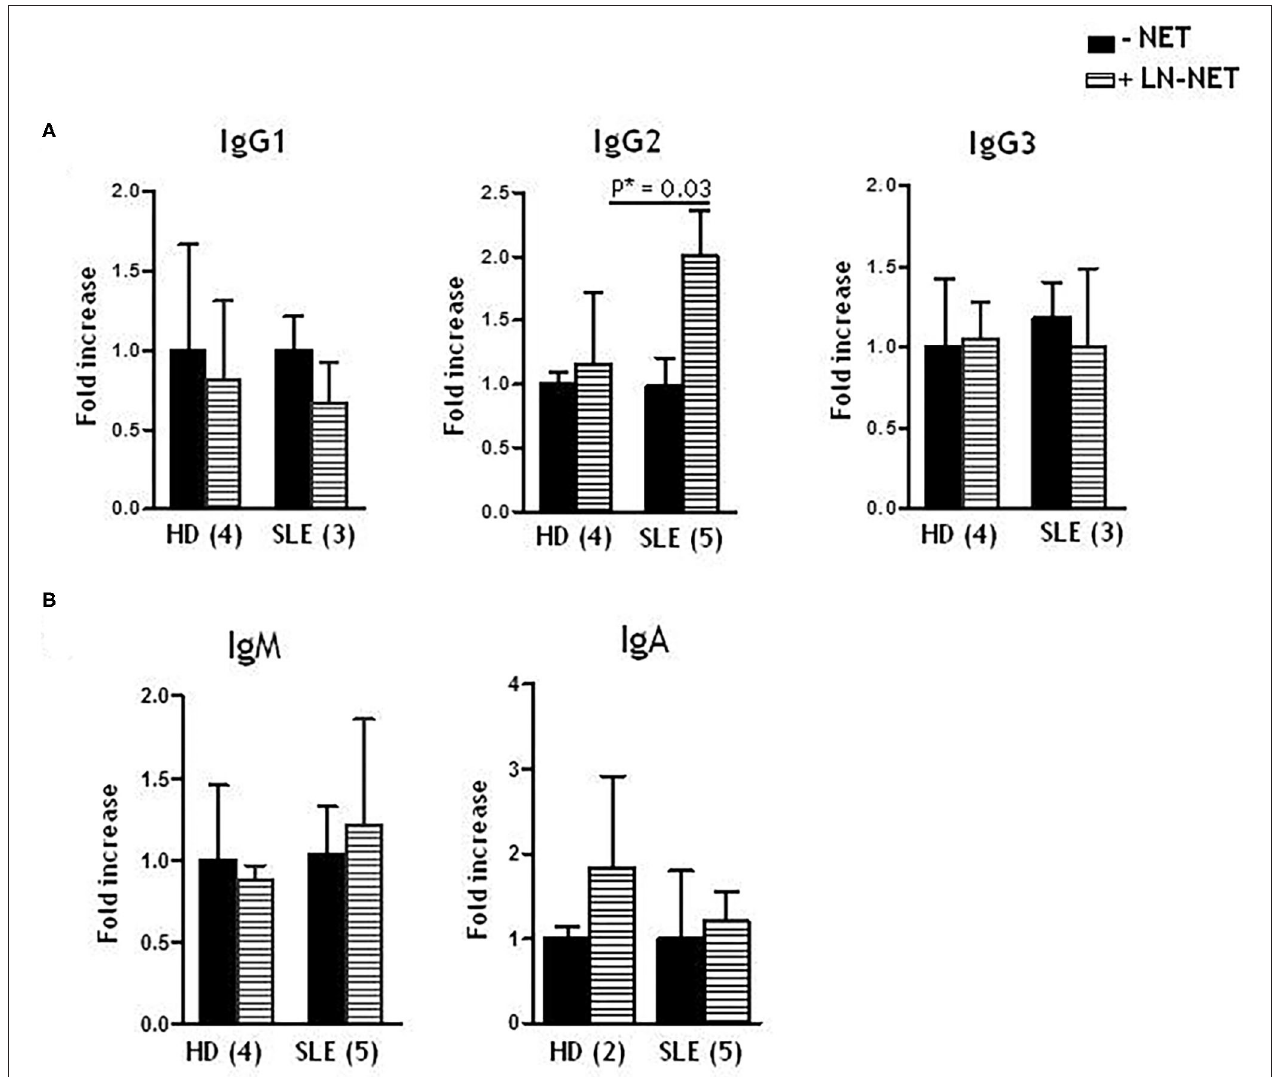
FIGURE 2 | Effect of NET on soluble IgG isotypes, IgM and IgA production. Naïve B cells, derived from healthy donors (HD) or SLE patients, were cultured as described in Materials and Methods. Where indicated (dashed bars), NET extracts were added after 5 days of culture. Immunoglobulins levels were determined by ELISA assay on cell supernatants, collected after 7 days of culture. Values indicate the fold increment of IgG1, IgG2, IgG3 (A) , IgM, IgA (B) , elicited by NET treatment, vs. untreated cells, and represent the mean of independent experiments indicated in figure. T cells, as well as T follicular helper (Tfh) and Th17 cells.